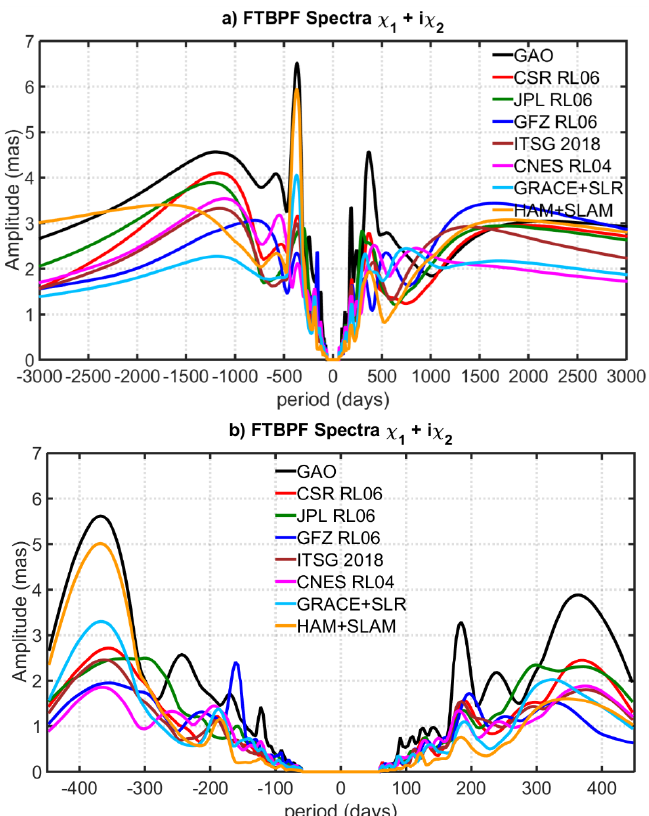
Figure 3. Fourier Transform Band Pass Filter (FTBPF) amplitude spectra of the GAO, GSMAM, GRACE + SLR, and HAM + SLAM computed in a broadband with ( a ) a 60–3000 day cut-off and ( b ) 60–450 day cut-off. The parameter λ describing the filter bandwidth when computing the FFBPF spectra was equal to 0.018. The minus time period on the plot indicates retrograde terms while plus time period indicates prograde terms.